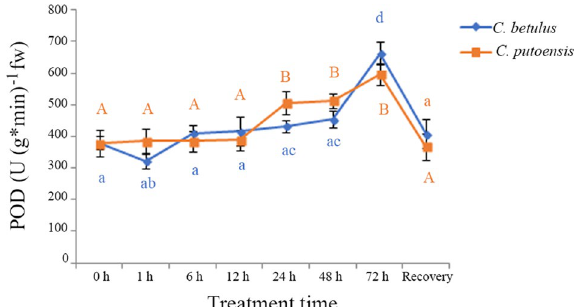
Figure 3. Changes in POD activity of C. betulus and C. putoensis at different time points of NO 2 stress and after self recovery. Letters or letter combinations containing the same letter indicate no significant difference between the corresponding NO 2 exposure time points in the same plant species according to ANOVA or nonparametric Kruskal–Wallis ANOVA followed by Bonferroni tests. Capital letters for C. putoensis and lower letters for C. betulus.